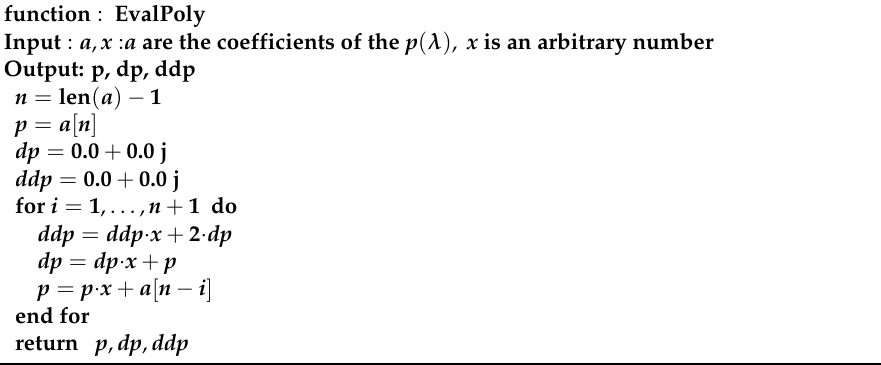
Table 4. Algorithm EvalPoly for polynomial derivatives. Table 5. Polynomial roots by Laguerre’s